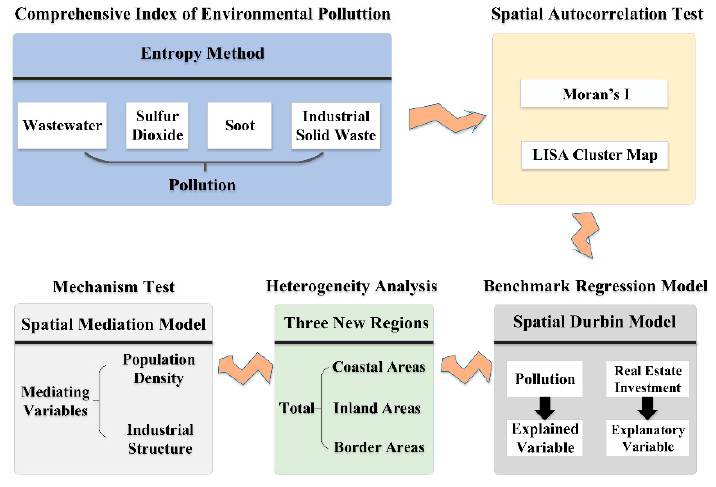
Figure 1. Analysis Figure 1. Analysis framework.